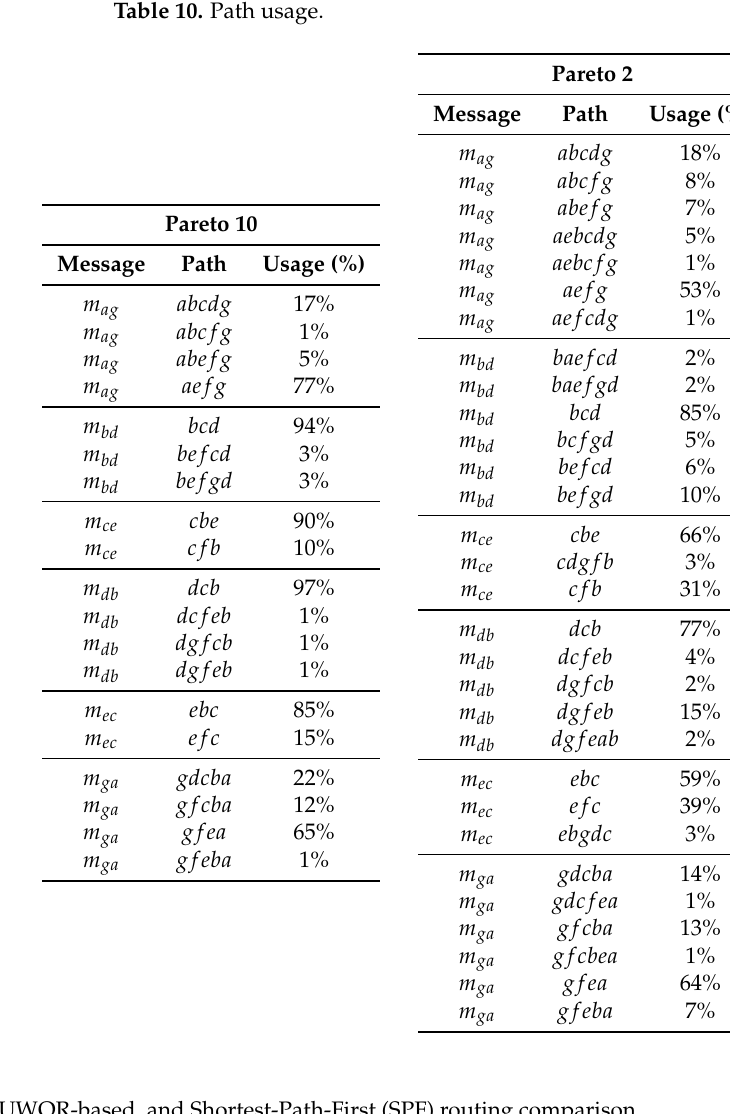
Table 11. Epidemic, UWOR-based, and Shortest-Path-First (SPF) routing